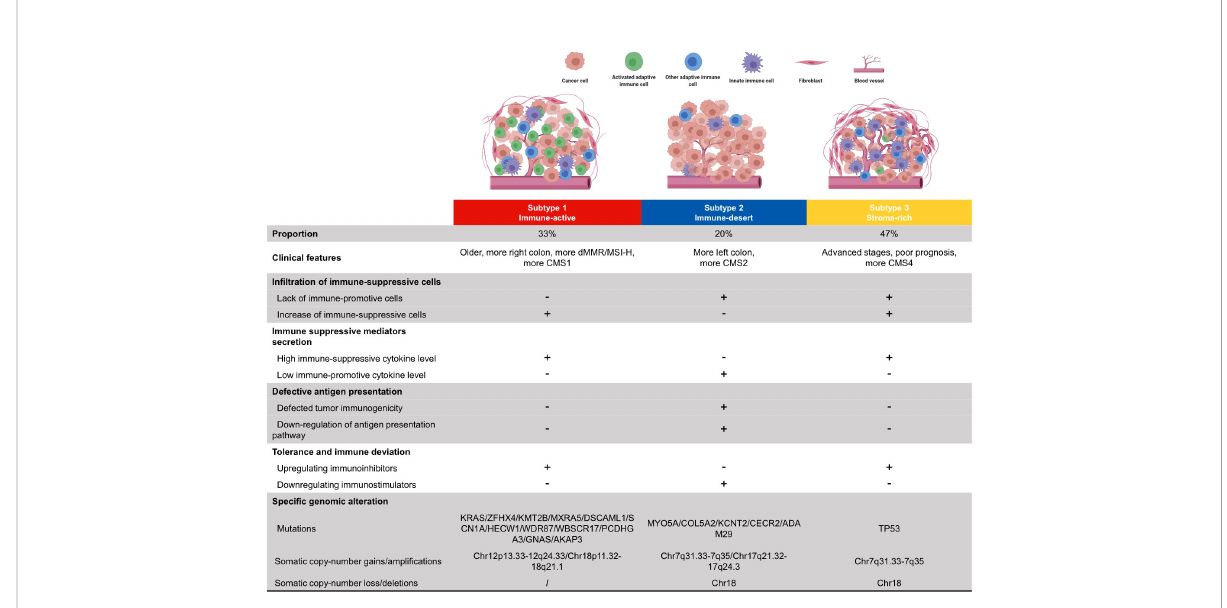
FIGURE 6 Summary of clinical features, immune escape mechanisms, and subtype-speci fi c genomic alterations of three TMEC